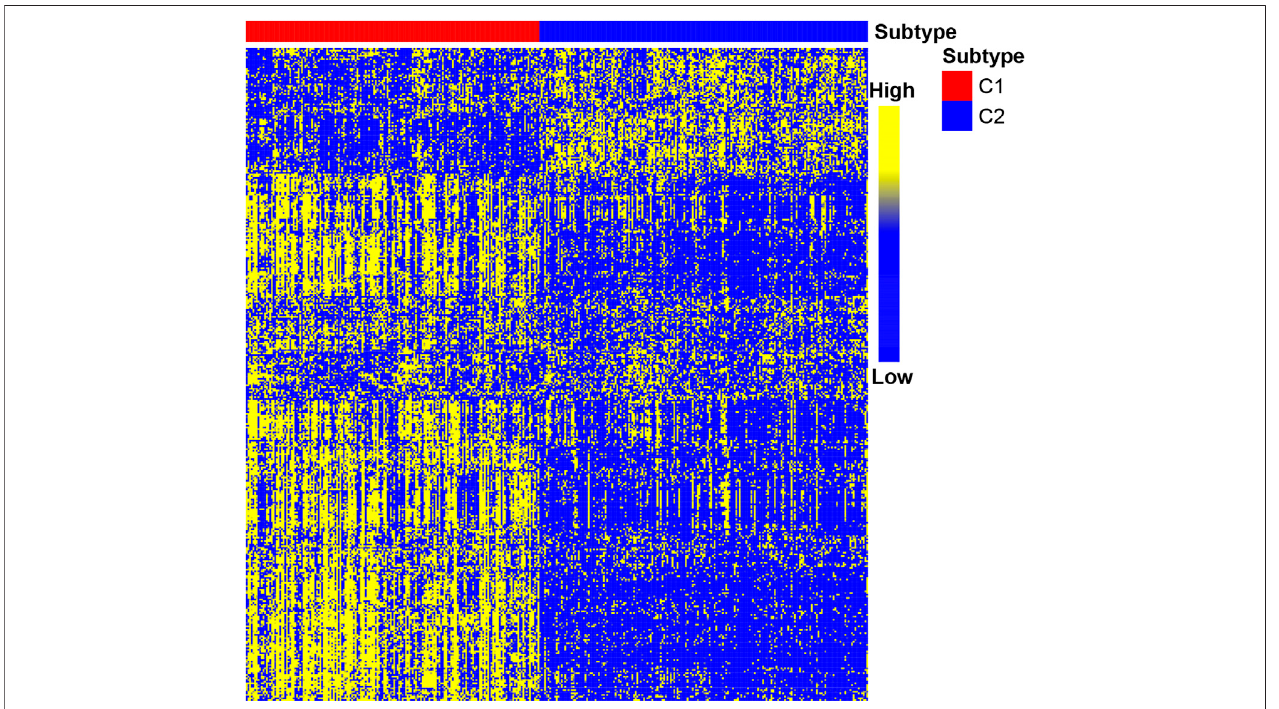
FIGURE 2| Heat map ofC1/C2 in TCGA cohort. TCGA cohort was used as adiscovery set, and 390 immune-related geneswere selected for the developmentof subtypes.Dataarepresentedinamatrixformat,inwhichrowrepresentsanindividualgeneandeachcolumnrepresentsasample.Thecolorinthecellsre fl ectsrelatively high (yellow) and low (blue) expression